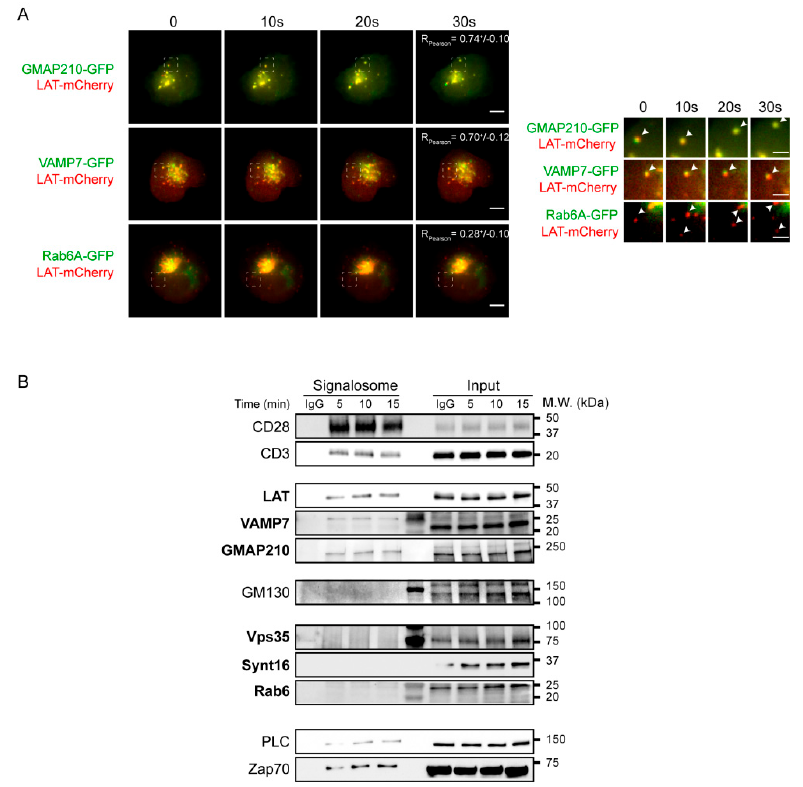
Figure 3. Anterograde, but not retrograde, pathway regulators are recruited together with LAT at the immune synapse. ( A ) Still images from live TIRFM imaging of Jurkat cells co-expressing LAT-mCherry and GMAP210-GFP, VAMP7-GFP or Rab6-GFP, seeded on coverslips coated with anti-CD3 ε +anti-CD28 Abs. Pearson correlation coefficient is shown (Mean ± SD). Dashed square indicate the magnified regions. Arrow heads point out the appearance and displacement in the evanescent field of vesicles-containing simultaneous or individual LAT and GMAP210/VAMP7 or Rab6, respectively. Scale bars = 5 µ m. Inset scale bars = 2 µ m. ( B ) Immunoblot of signalosomes prepared from Jurkat cells activated for 5, 10 or 15 min with anti-CD3 ε +anti-CD28 coated magnetic beads. IgG corresponds to Jurkat cells incubated with irrelevant mAb coated magnetic beads for 15 min. Proteins attached to the beads were purified by magnetic sorting after freezing and thawing the cells. Presence of the different proteins in the corresponding cell lysates (with detergent) are shown in “input” lanes. Data and images represent two independent experiments in ( A , B